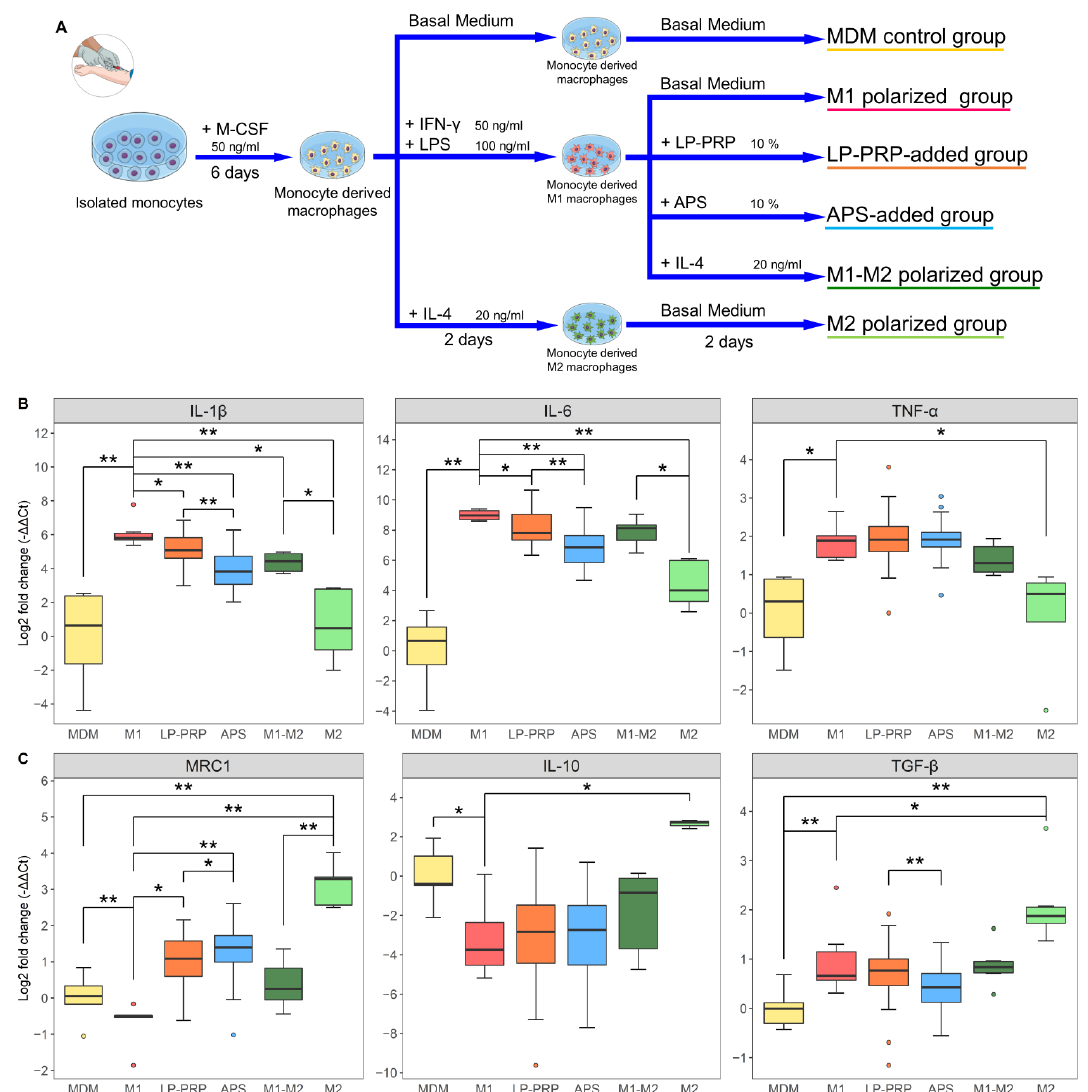
Figure 5. Effect of PRPs on M1 macrophages. ( A ) After CD14 + monocytes were isolated by the same method as described in Figure 3, they were cultured in a basal medium supplemented with 10% FBS containing M-CSF at 37 °C under 5% CO 2 . After six days, the media was replaced by fresh basal medium supplemented with 10% FBS containing IFN-γ + LPS, and the cells were cultured for another two days to polarize them to M1 macrophages. The medium was removed, the basal medium supplemented with 10% FBS containing supernatants obtained from LP-PRP or APS was added, and the cells were cultured for another two days. ( B ) Expression of M1 macrophage markers (IL-1β, IL-6, TNF-α). ( C ) Expression of M2 macrophage markers (MRC1, IL-10, TGF-β). Data were analyzed through qRT-PCR. -ΔΔCt values were calculated using GAPDH as an internal control. MDM control and M1 polarized groups served as negative controls; M1-M2 and M2 polarized groups served as positive controls. MDM control, M1 polarized, M1-M2 polarized, M2 polarized groups: 6 monocyte donors, 1 experiment, n = 6 per group; LP-PRP- and APS-added groups: 6 monocyte donors, 12 PRP donors, n = 72 per group. * p <0.05, ** p <0.01.